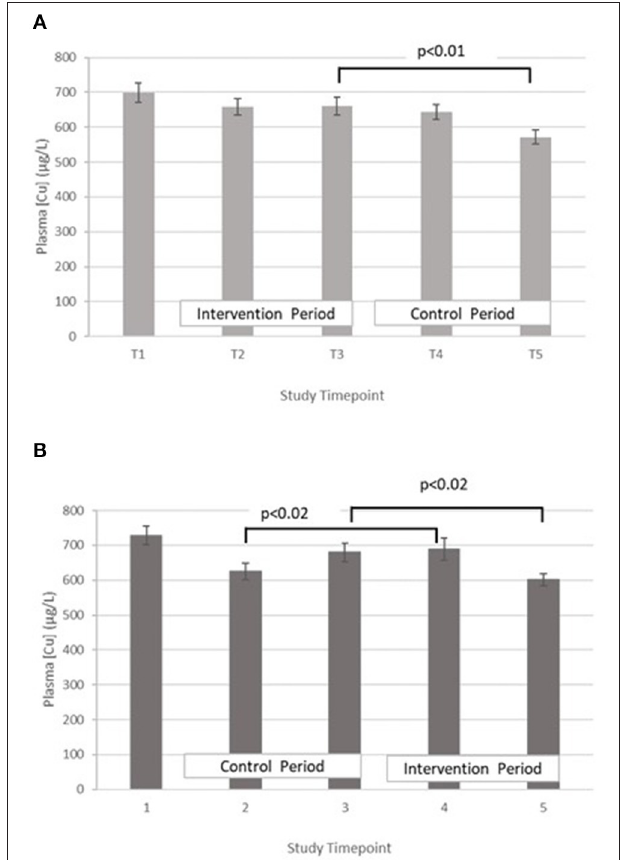
FIGURE 4 | (A) Plasma copper concentration measured in Group A at baseline (T1), week 4 of period 1 (T2), week 8 of period 1 (T3), week 4 of period 2 (T4) and week 8 of period 2 (T5). Bars indicate estimated marginal means with standard error. (B) Plasma copper concentration measured in Group B at baseline (T1), week 4 of period 1 (T2), week 8 of period 1 (T3), week 4 of period 2 (T4) and week 8 of period 2 (T5). Bars indicate estimated marginal means with standard